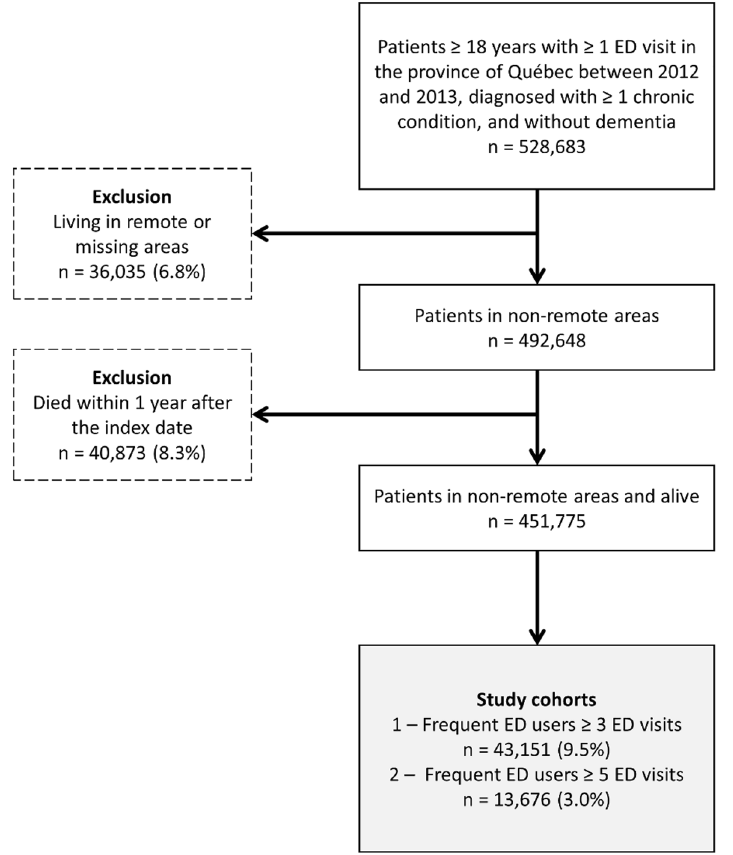
Figure 1. Flowchart of the study